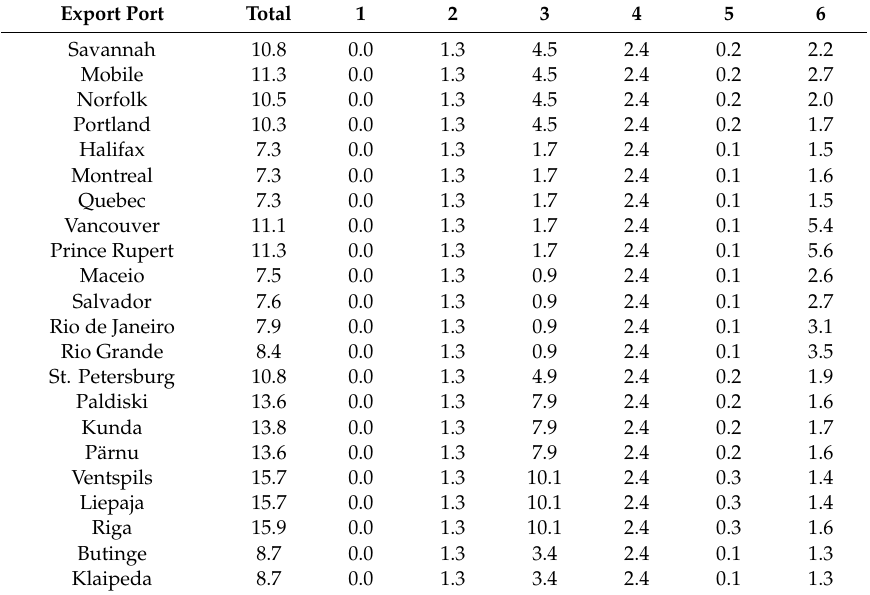
Table A14. Overview of supply chain GHG emissions of torrefied pellets produced from sawmill residues, transported over 500 km to export ports and including 50 km feedstock transport, in kg CO 2- eq / t pellets. Components included in the table: 1. Silviculture and harvest; 2. Feedstock transport;